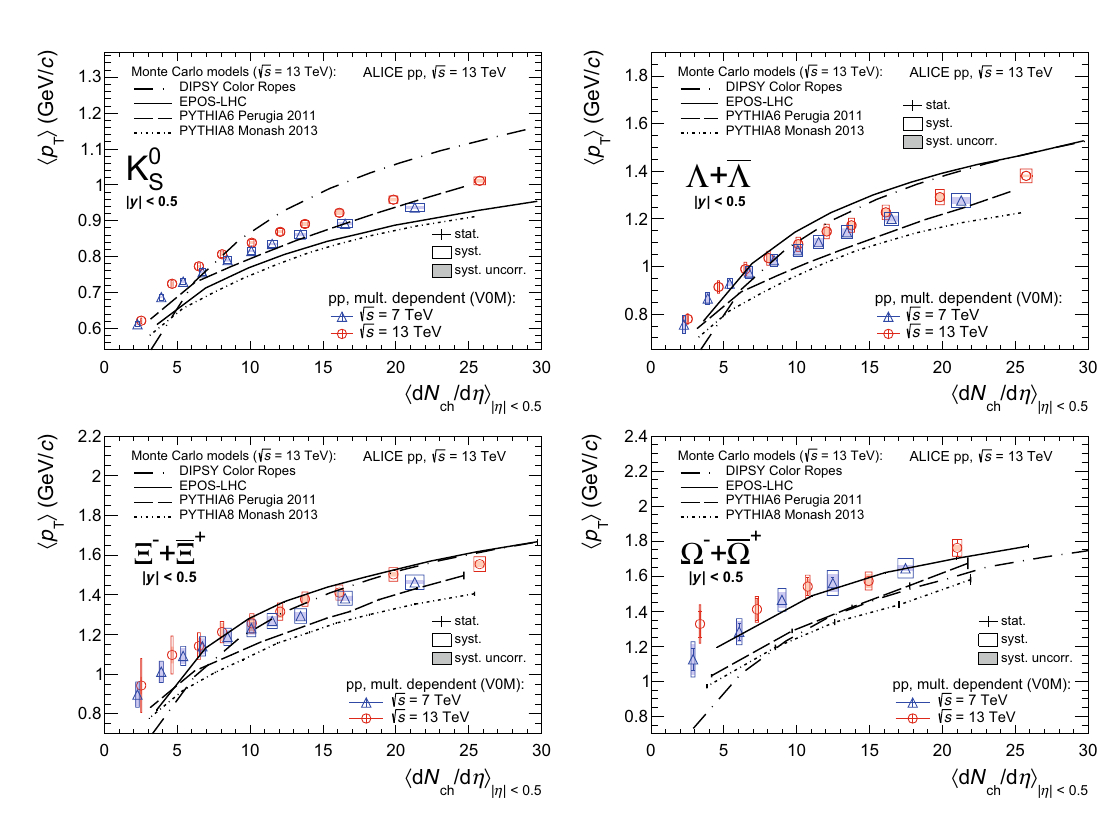
Fig. 12 (cid:3) p T (cid:4) of K 0 , (cid:3) , (cid:4) , and (cid:5) as a function of d N ch / d η in V0M √ S s = 7 and 13 TeV. Statistical and system- multiplicity event classes at aticuncertaintiesareshownbyerrorbarsandemptyboxes,respectively.